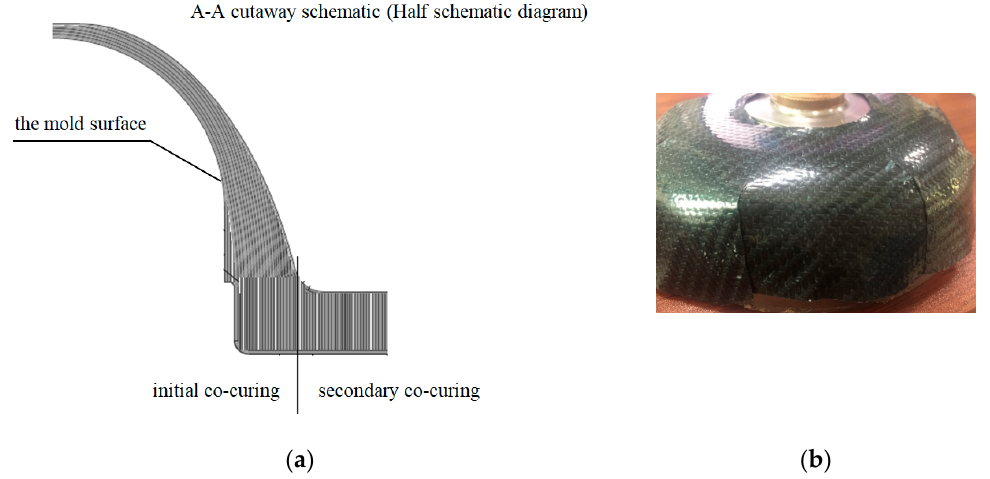
Figure 3. Lay-up diagram of the preferred scheme: ( a ) lay-up diagram ( b ) cutting opening mode. Table 2. The layering table of the connector structure.